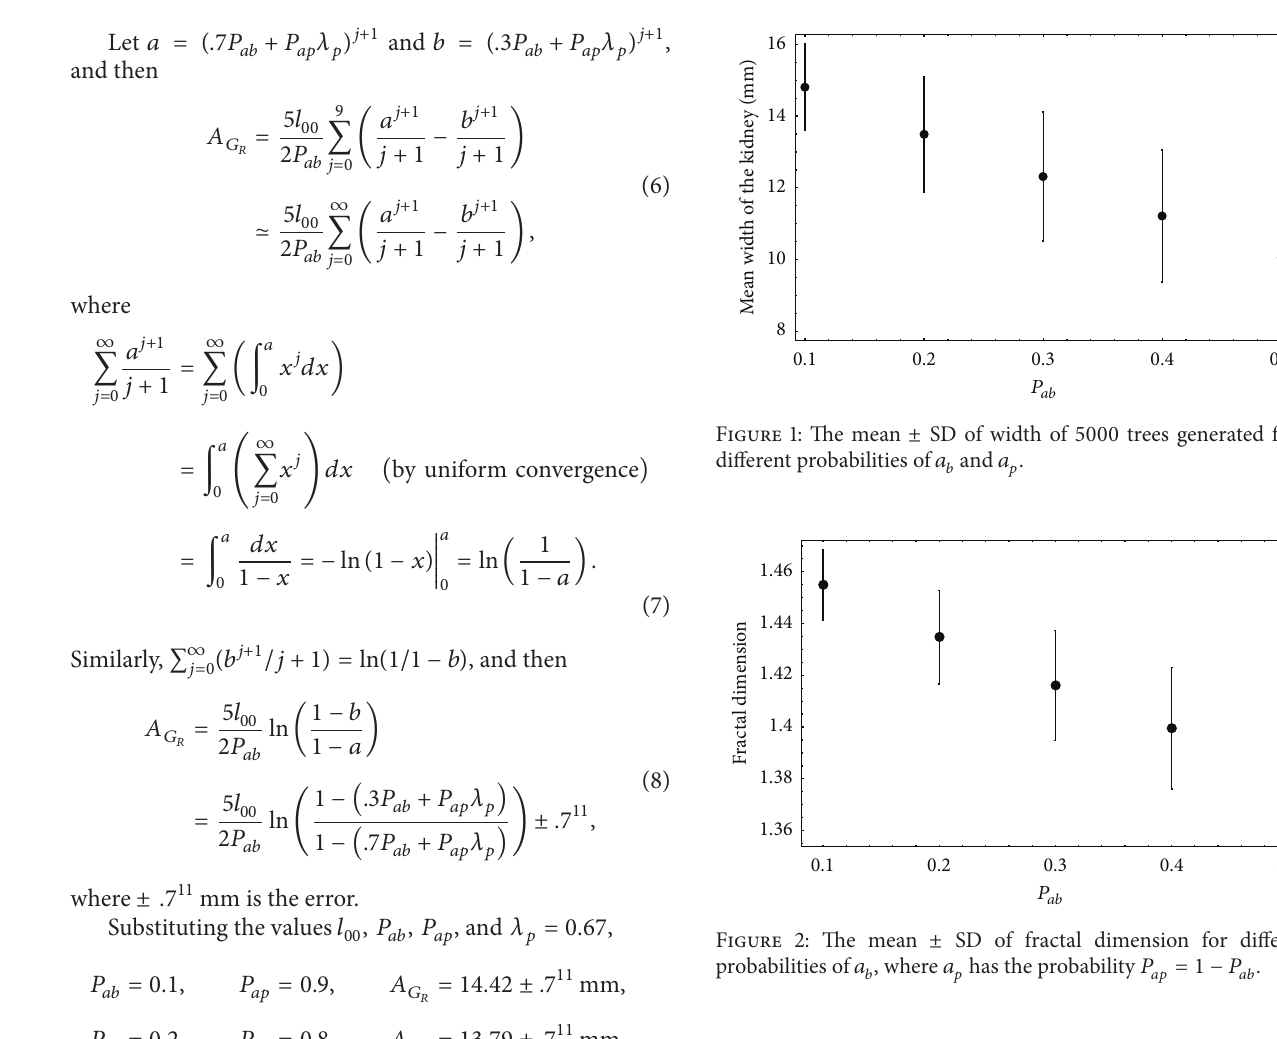
iterative function system (IFS), and let 𝐴 denote its